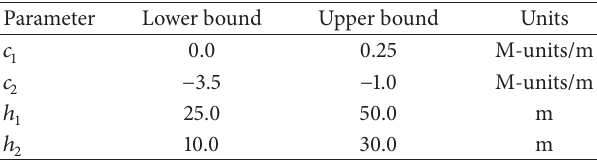
Table 1: The lower and upper search bounds of the parameters.